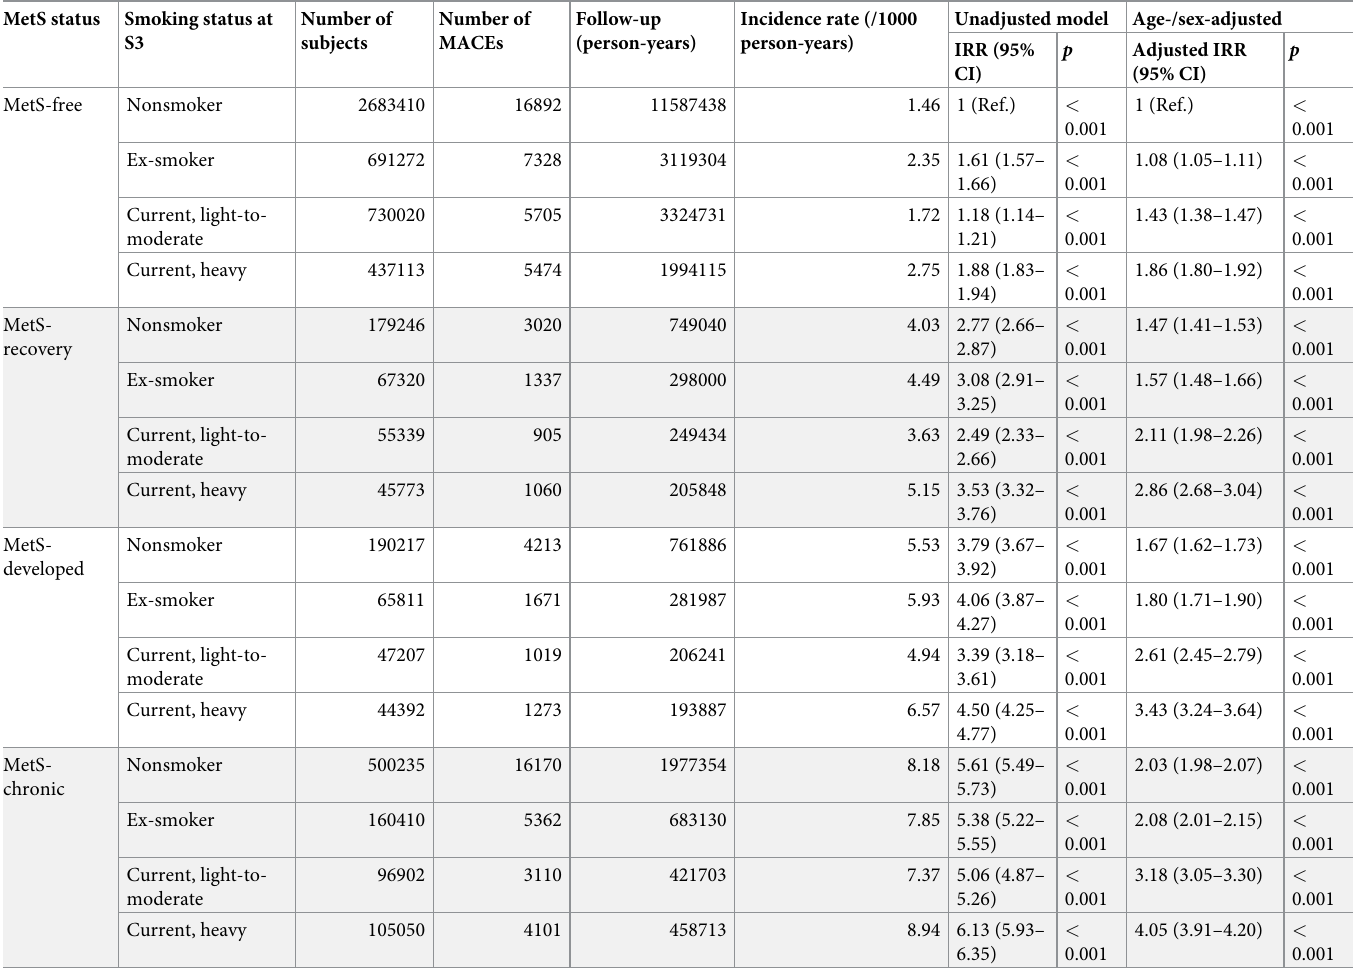
Table 3. Risks of major adverse cardiovascular events according to smoking status at S3 and dynamic metabolic syndrome